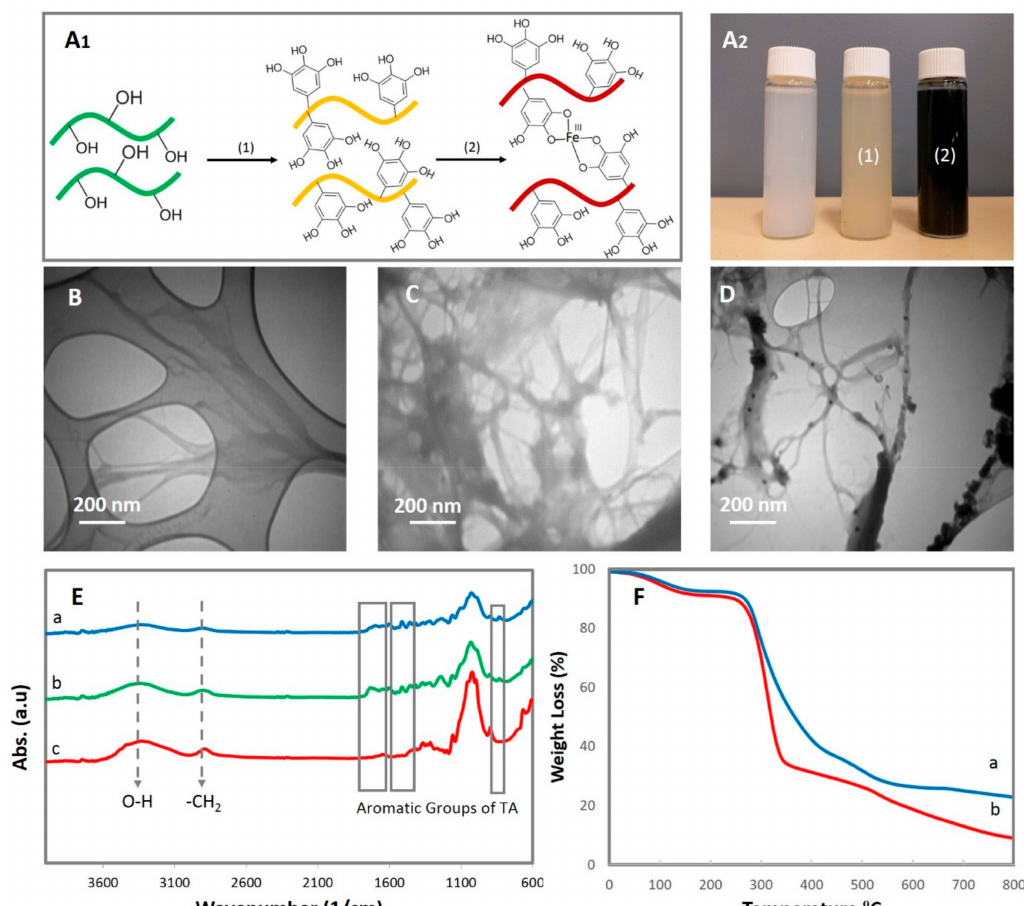
Figure 1. ( A 1 ) Schematic of depositing TA and Fe ions onto ChNFs and ( A 2 ) the color change of ChNFs after loading TA and Fe ions respectively, TEM image of ( B ) ChNFs, ( C ) TA-ChNFs, ( D ) Fe/TA@ChNFs, ( E ) FTIR results of ( a ) Fe/TA@ChNFs, ( b ) TA@ChNFs, ( c ) ChNFs, and ( F ) thermal stability of ( a ) Fe/TA@ChNFs and ( b ) TA@ChNFs.